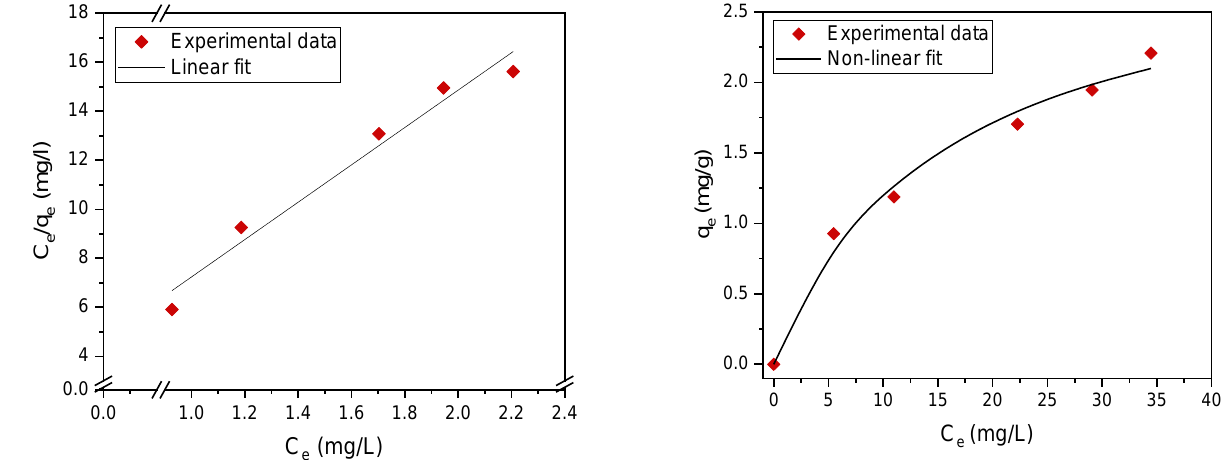
Figure 7. Langmuir adsorption isotherm nonlinear fit ( right ) and linear fit ( left ).